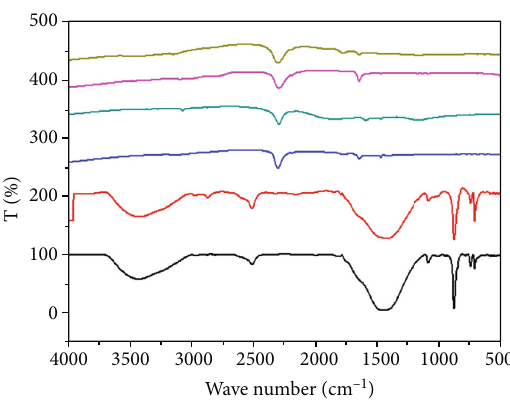
Figure 12: FT-IR test of cement